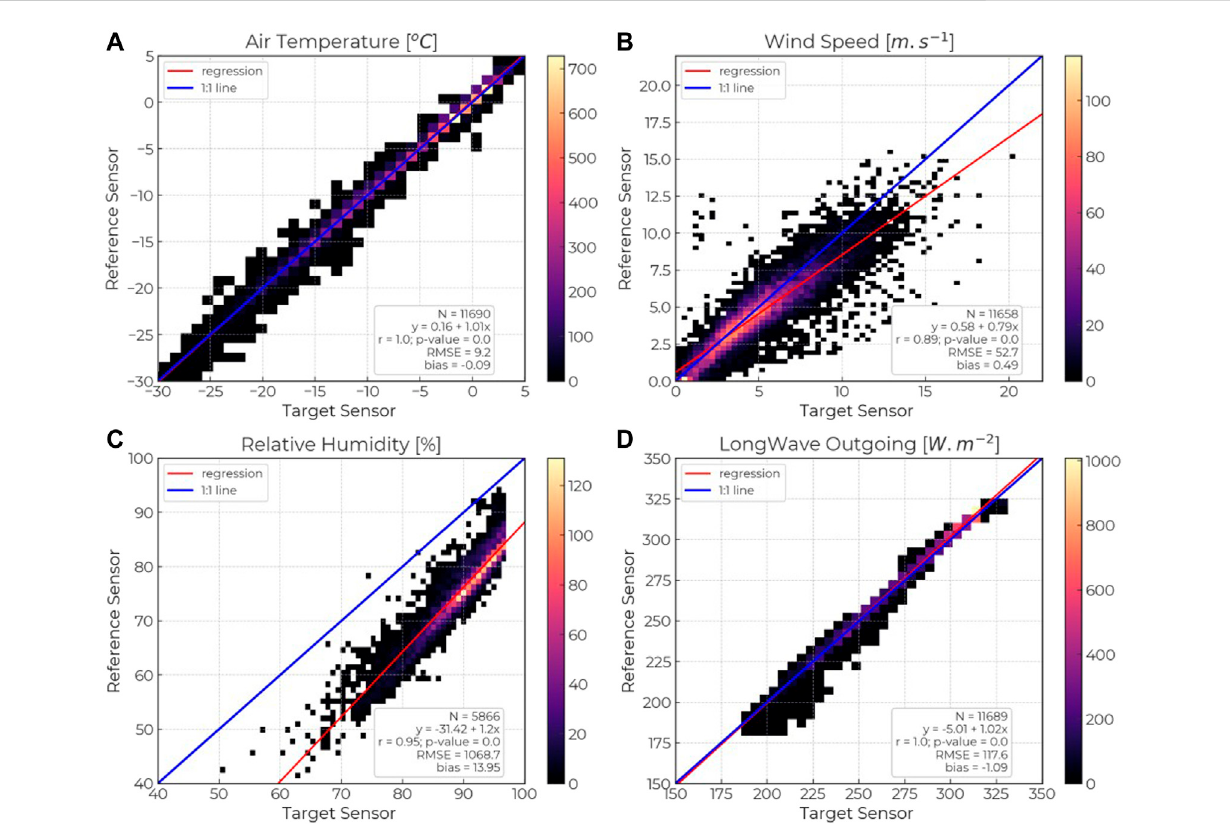
FIGURE 8 Bi-variatehistogramsofthereferencesensor(classicalweathermast) vs. thecorrespondingsensorfromtheadjacentnode sw-215 .Noprocessingis applied except discarding outliers.1:1 line (blue) and a linear regression fi t (red) are overlaid onto the histogram. The colorscales indicate the count of common